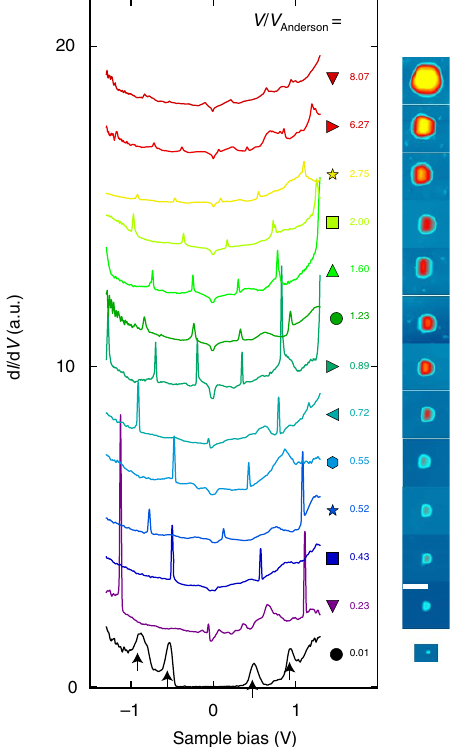
Figure 3 | DCs for increasing NC volume. The coloured symbols identify the corresponding data points in Figs 2f,h and 5. For each spectrum, the corresponding NC and the volume ratio V / V Anderson are shown on the right. Note that for the smallest NC (bottom black curve) no Coulomb peaks are observed, instead a large Coulomb gap and broad quantum well peaks are